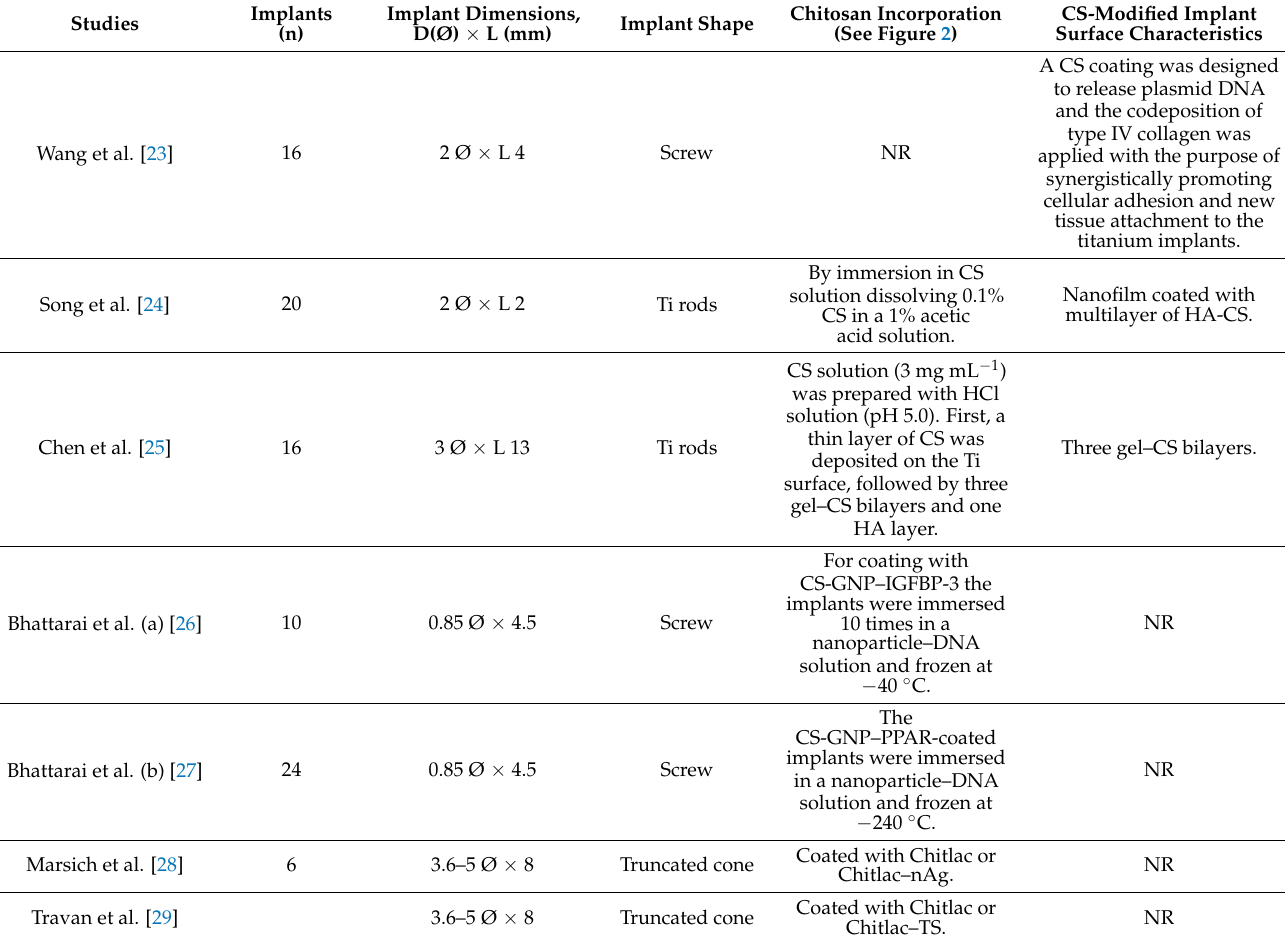
Table 3. Characteristics of